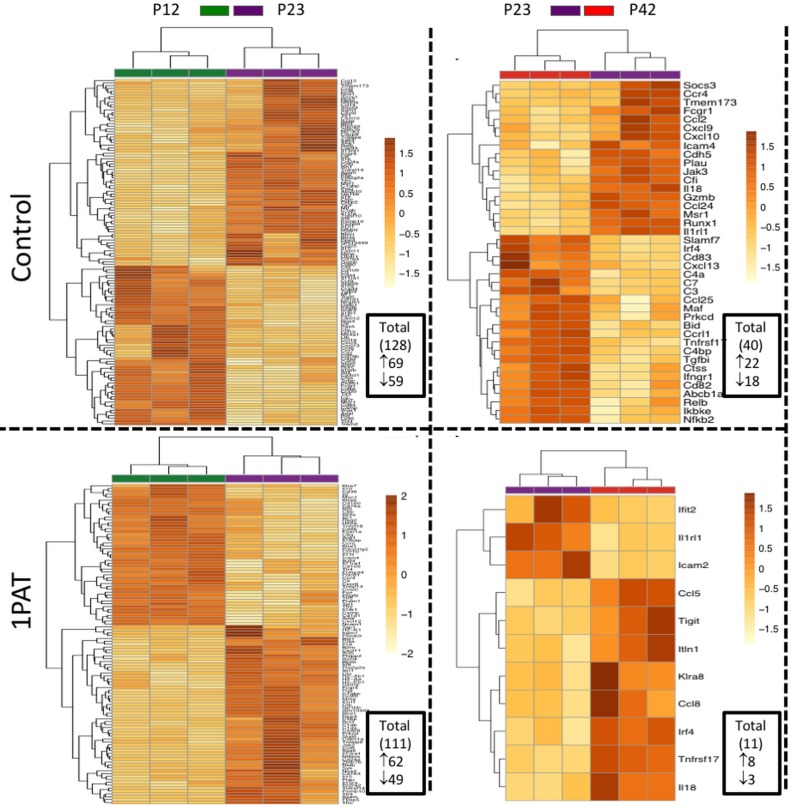
PAT effect on the maturation of ileal immune gene profiles in male NOD mice, as assessed by NanoString nCounter assays and shown on heat maps.Genes differentially expressed between P12 and P23 (left) and between P23 and P42 (right) are shown for control (top) or 1PAT mice (bottom). Significantly more ileal genes showed maturity of expression between P12 and P23 than between P23 and P42, in both the control and the 1PAT mice, (p<0.0001 for both, Chi-square analyses). The differential gene list can be found in Supplementary file 6.